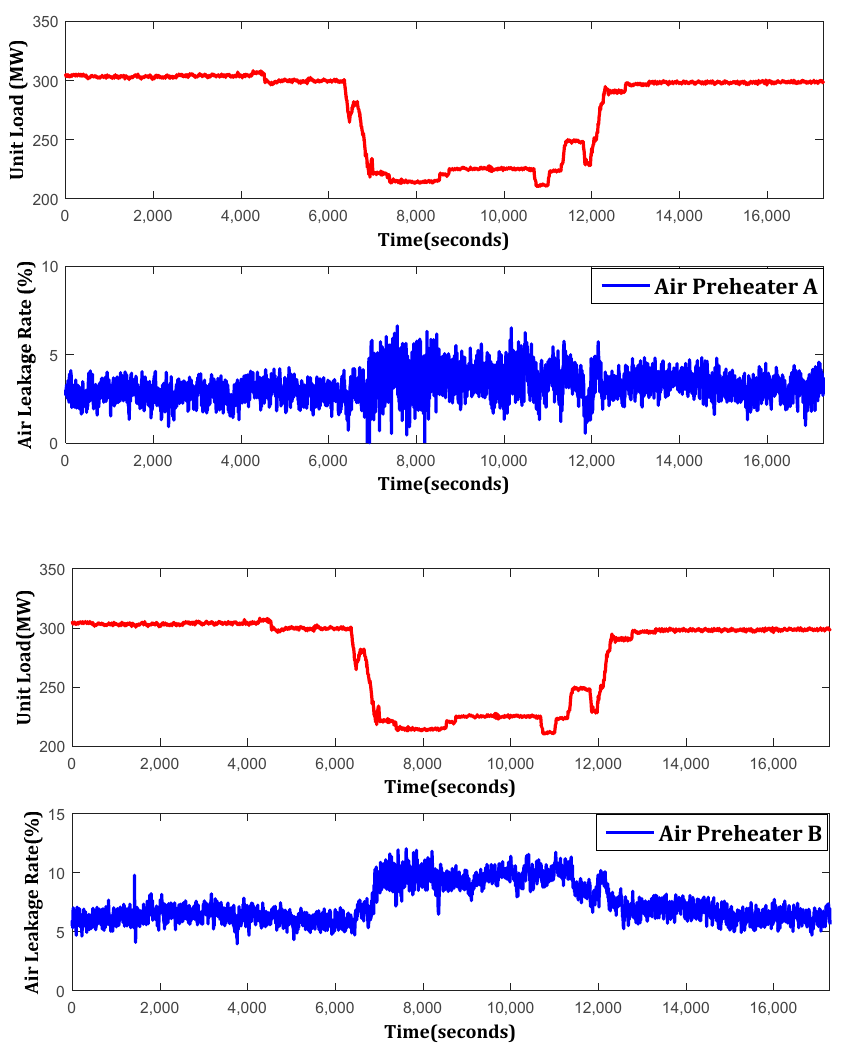
Figure 3. Air leakage rate measurement results.